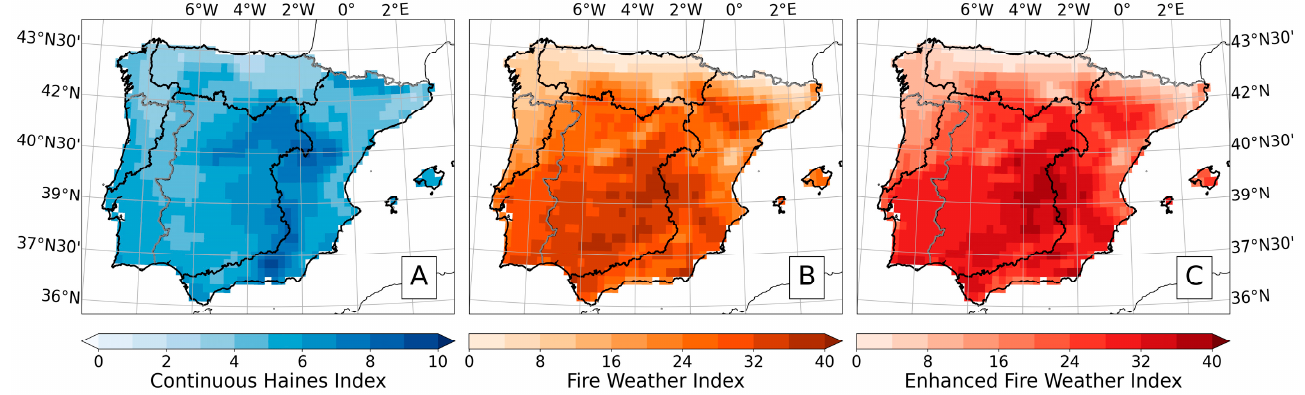
Figure 2. Field climatologies for the Iberian Peninsula for the 1980–2020 period considering the summer months of June, July, August, and September (JJAS) for the three indexes ( A ) CHI, ( B ) FWI, and ( C ) FWIe.